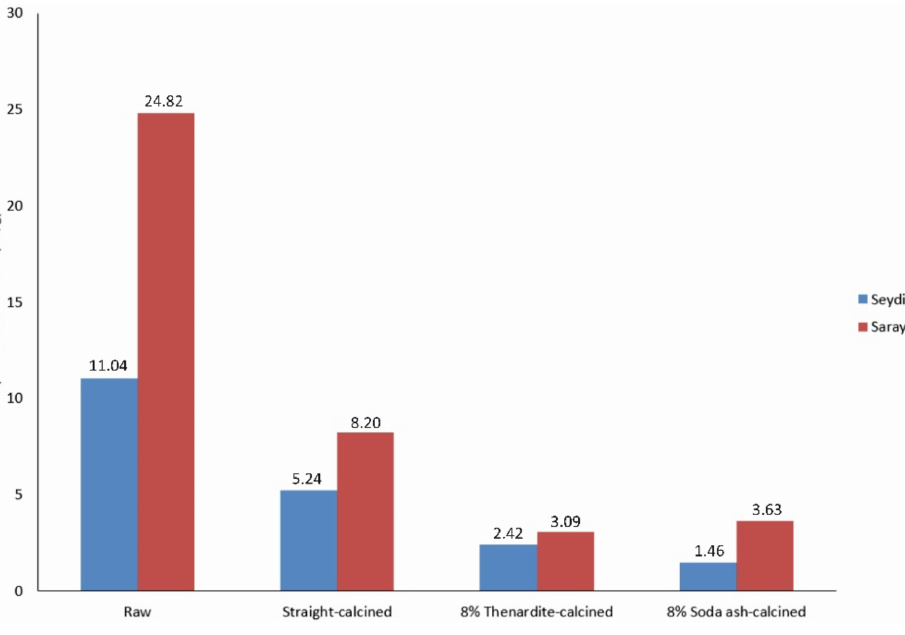
Figure 7. Specific surface area values of diatomite